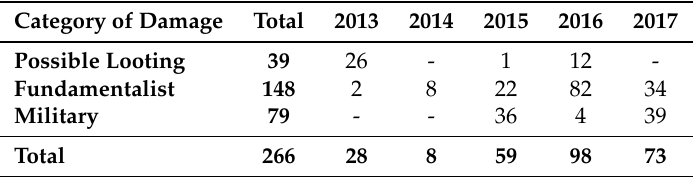
Table 4. Distribution of the damage (total and per year) grouped by category.